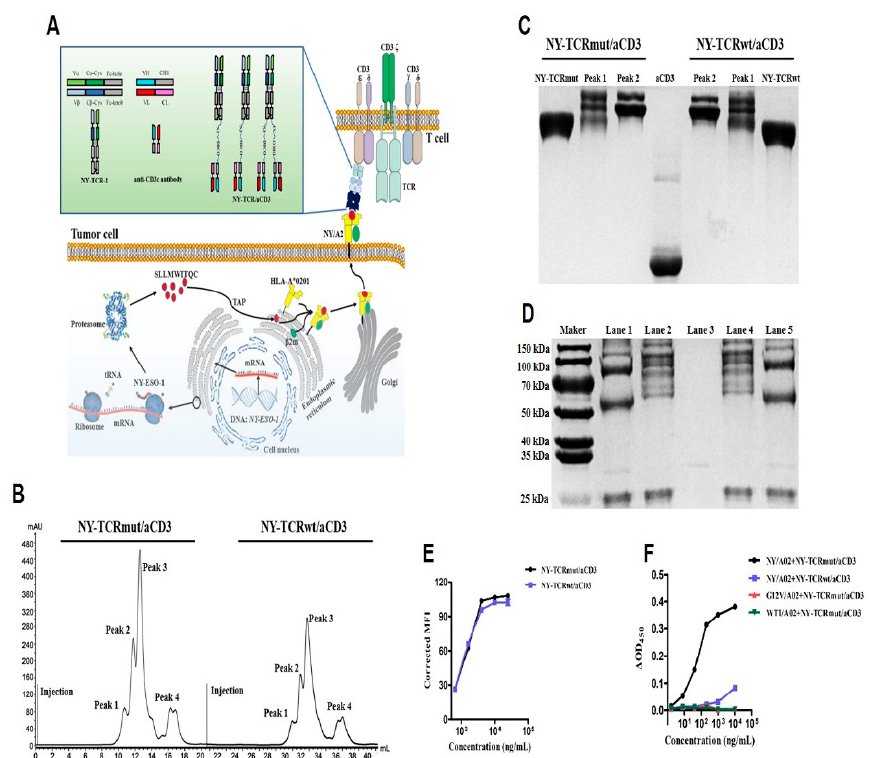
Figure 2. Generation and analysis of NY-TCR/aCD3. ( A ) NY/A02 as the target of TCR/aCD3. Peptides (SLLMWITQC) derived from proteasome digestion are presented to the cell surface by HLA-A*0201, where they are recognized by NY-TCR as the pHLA(NY/A02). NY-TCR/aCD3 was generated through chemo-enzymatic conjugation that can mediate T cell immune response by simultaneously recognizing T cells and tumor cells. ( B ) Purification of NY-TCR/aCD3 using molecular exclusion chromatography. Four peaks were observed, and the products of Peak 1and Peak 2 were collected for further analysis. ( C ) Analysis of the products of Peak 1and Peak 2 using SDS-PAGE in non-denatured condition. The composition of Peak 1is mixed. The molecular size of the two components of Peak 2 is larger than that of NY-TCR, suggesting that one NY-TCR may successfully conjugate with one or two aCD3. ( D ) Analysis of the products of Peak 2 by SDS-PAGE in denatured condition after being deglycosylated using PNGase F. Lane 1: deglycosylated NY-TCRmut/aCD3. Lane 2: glycosylated NY-TCRmut/aCD3. Lane 3: PNGase F. Lane 4: glycosylated NY-TCRwt/aCD3. Lane 5: deglycosylated NY-TCRwt/aCD3. Glycosylated NY-TCR/aCD3 have a variety of components with different molecular sizes, and deglycosylated NY-TCR/aCD3 contain three components: α or β chain of NY-TCR (~50 kDa), aCD3-H conjugated α or β chain of NY-TCR (~75 kDa), and aCD3-L (~23 kDa). ( E ) Binding ability analysis of NY-TCR/aCD3 to Jurkat cells (CD3 ε + , n = 3). NY-TCRmut/aCD3 and NY-TCRwt/aCD3 have a similar affinity to CD3 ε . ( F ) Affinity analysis of NY-TCR/aCD3 to NY/A02 and irrelevant pHLA (n = 3). NY-TCRwt/aCD3 had a weak affinity to NY/A02, while the affinity between NY/A02 and NY-TCRmut/aCD3 was significantly higher. NY-TCRmut/aCD3 did not show any affinity to irrelevant pHLA under otherwise identical